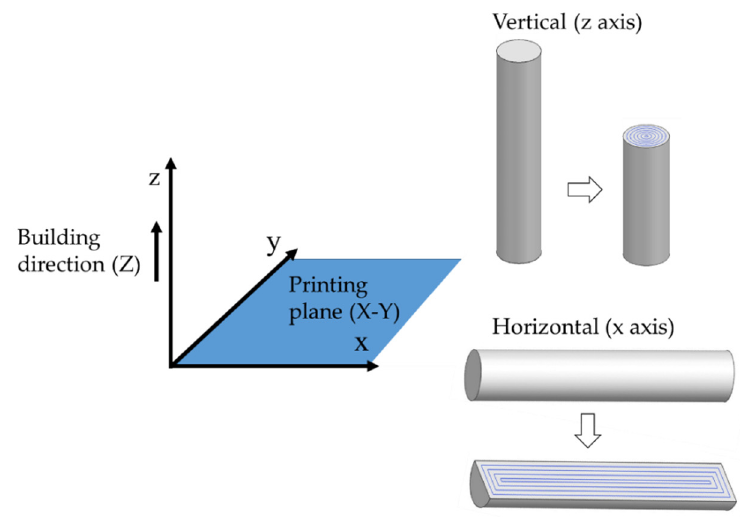
Figure 2. Infill pattern of the samples oriented in X and Z axes.